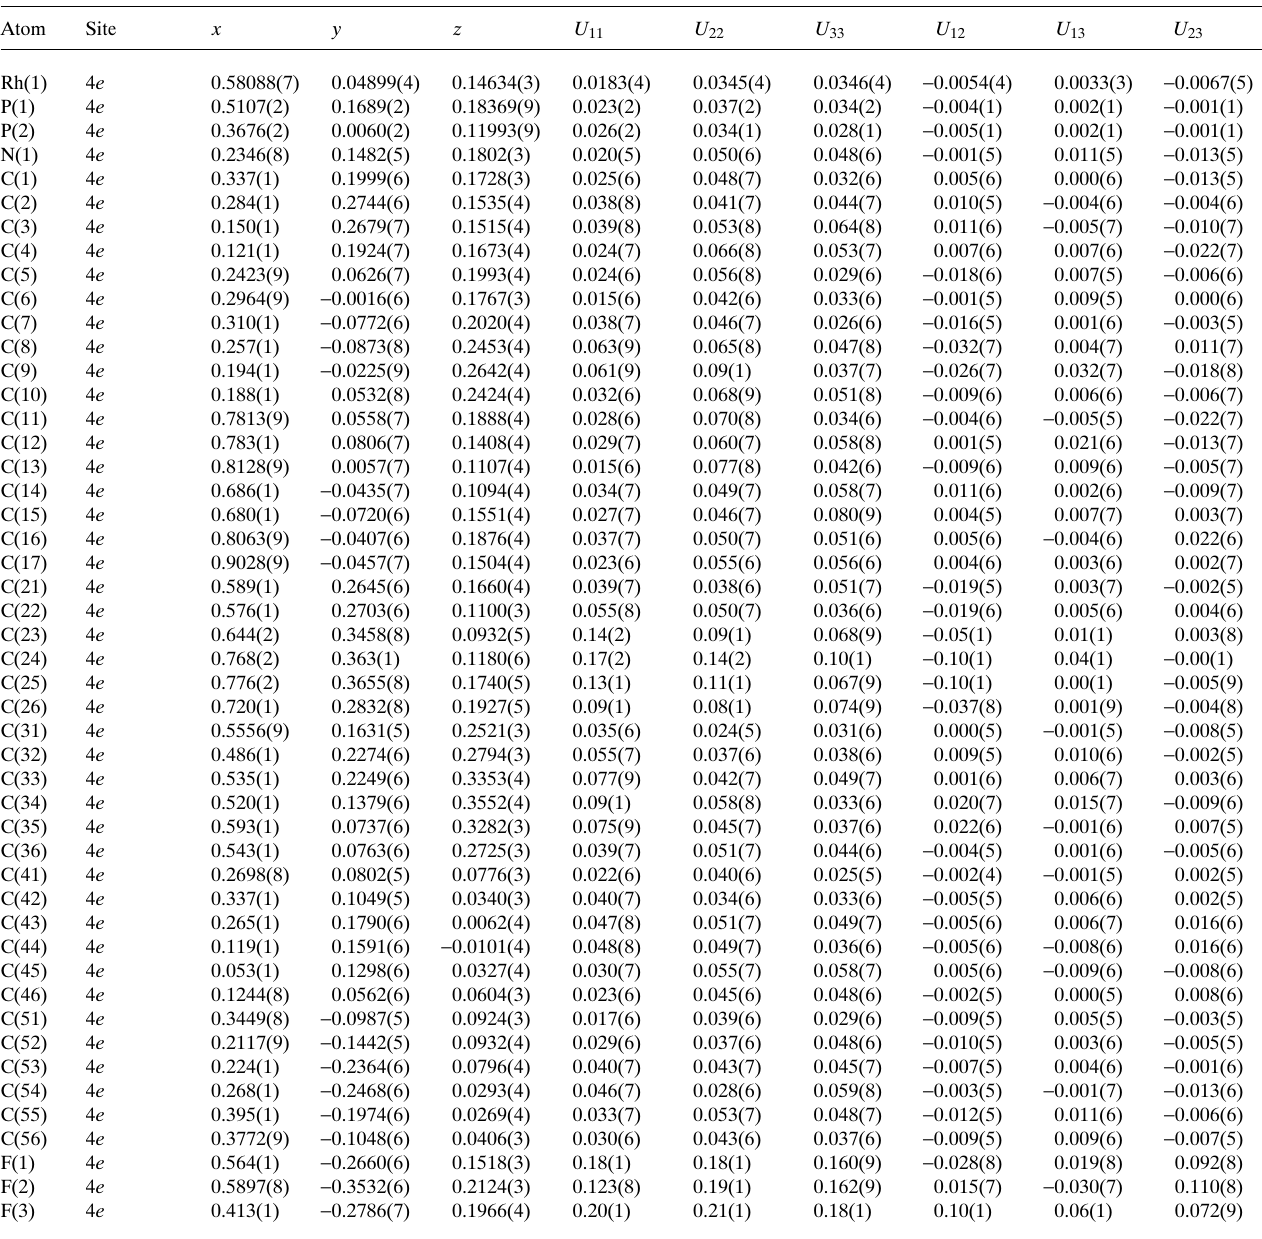
Table 3. Atomic coordinates and displacement parameters (in Å 2 )